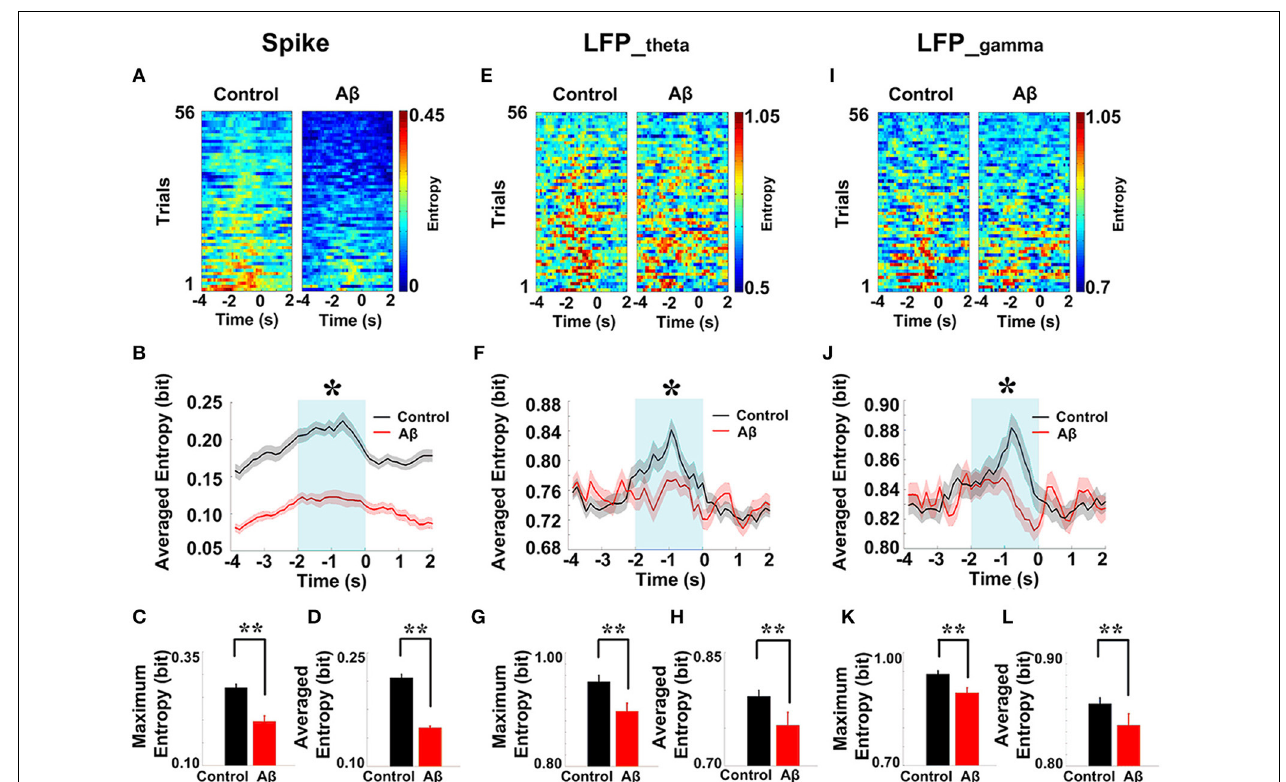
FIGURE 7 | Dynamic entropy of neural activity in rat PFC during the working memory task in the A β ( n = 56 trials) and control ( n = 56 trials) groups. (A) Dynamic entropy of spikes from example trials (left: control; right: A β ). (B) Averaged entropy of spikes across all trials in A β (red) and control (black) groups. The shaded region indicates s.e.m. The light blue area indicates the period used for statistical analysis. Averaged entropy values were compared between two groups in this